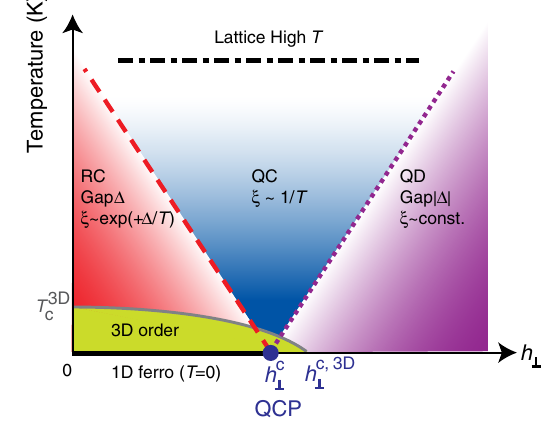
FIG. 1. A generic T − h ⊥ phase diagram of the TFIC encom- passes three scaling regimes with distinct behaviors of the spin- spin correlation length ξ : RC [ g < 1 , hence h ⊥ < h c ⊥ , and ξ ∼ exp ðþ Δ =T Þ ], QC ( ξ ∼ 1 =T ), and QD ( g > 1 , hence h ⊥ > h c ⊥ , and ξ ∼ constant) [6]. The dashed and dotted lines represent the crossover temperature from the QC to the RC regime at T ∼ Δ and from the QC to the QD regime at T ∼ j Δ j , respectively. An isolated 1D Ising chain would exhibit ferro- magnetic long-range order only at T ¼ 0 below h c ⊥ , but the 3D interchain couplings lead to a 3D order at T > 0 up to h c; 3 D ⊥ ( > h c ⊥ ). The filled circle at T ¼ 0 and the 1D critical field h c ⊥ represents the QCP of the individual Ising chain.